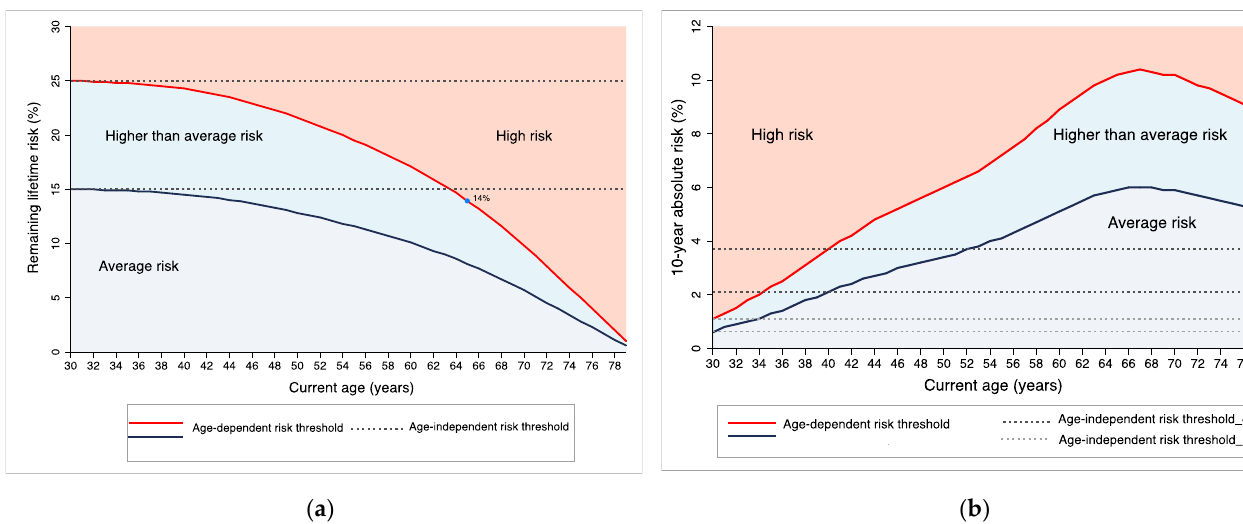
Figure 1. Age-dependent risk thresholds based on ( a ) remaining lifetime risk (from current age to age 80 years) and ( b ) ten-year absolute risk for breast cancer in women in Canada (2012–2016), where risk thresholds for the ‘high risk’ (red line) and ‘higher than average’ (blue line) risk categories have been set at remaining lifetime risks of 25% and 15%, respectively, if determined at age 30 (in ( a )) and age 40 (in ( b )). Risk categories: high risk (red line and above), higher than average risk (between the blue line and the red lines), and average risk (below the blue line). Grey dotted lines represent age-independent risk thresholds corresponding to 25% and 15% remaining lifetime risks (from age 30 to 80) ( a ) and 10-year absolute risks of 3.7% and 2.1% when assessed at age 40 are equivalent to 25% and 15% remaining lifetime risks at age 40 ( b ). Light grey dotted lines in ( b ) represent 10-year absolute risks of 1.1% and 0.63% when assessed at age 30, which are equivalent to 25% and 15% remaining lifetime risks also at age 30, respectively. Table 2. Age-specific relative risks associated with age-independent and age-dependent absolute risk thresholds for the high-risk category compared to the population average absolute risk, using remaining lifetime risk and 10-year absolute risk for breast cancer in women in Canada